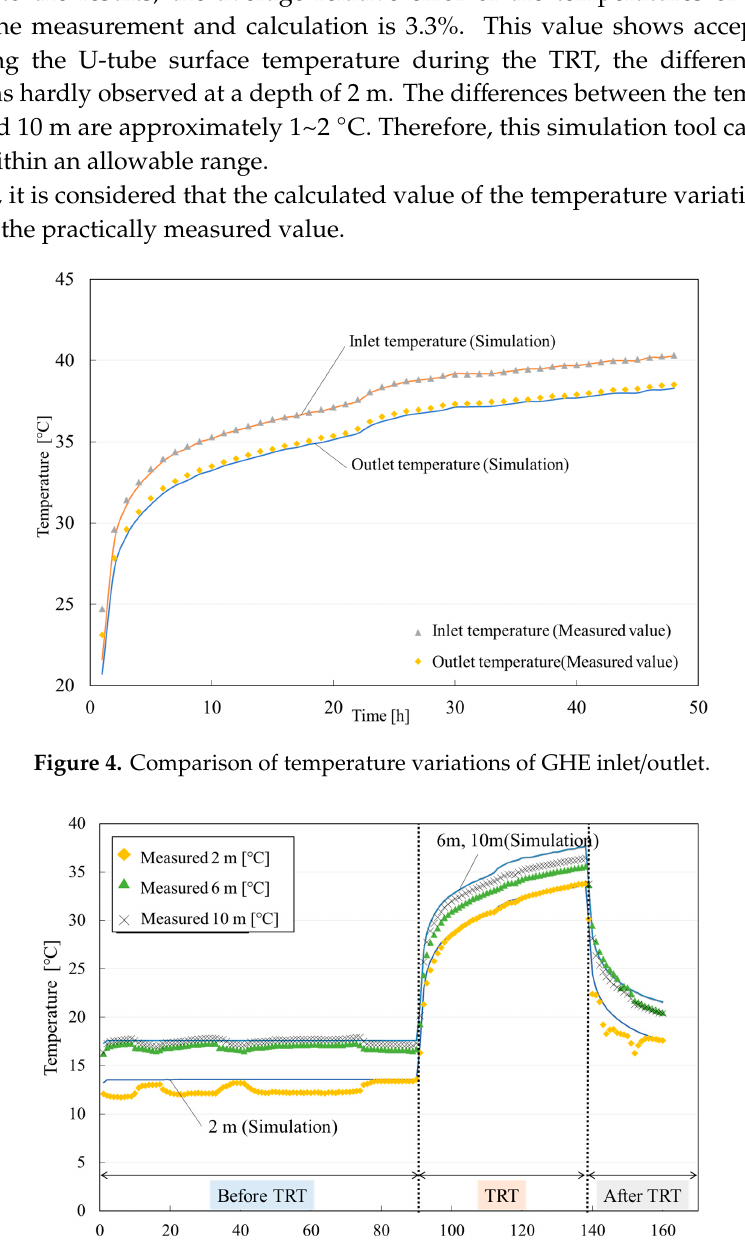
Figure 6. Schematic diagram of the TRT.